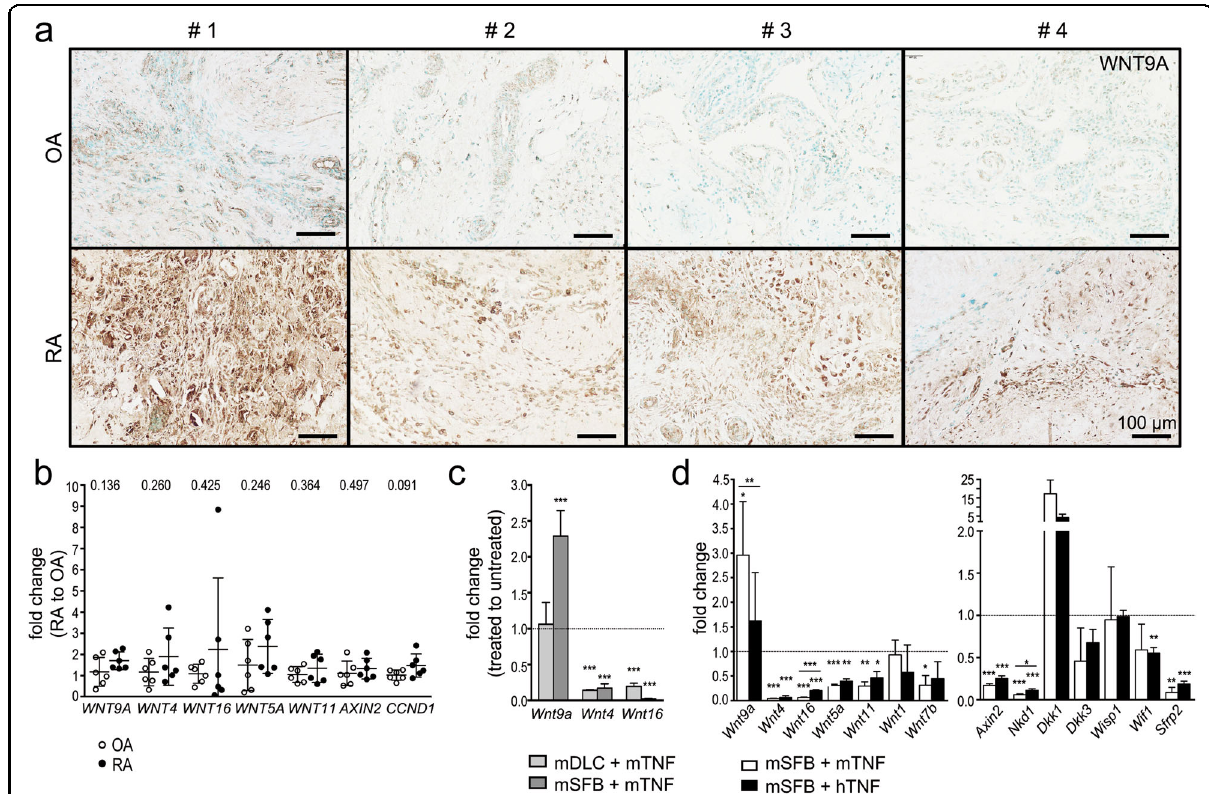
Fig. 1 Expression of Wnt genes under in fl ammatory conditions. a Immunohistological analysis of WNT9a in human OA and RA tissue samples ( n = 4). b qPCR analysis of WNT pathway-related genes in RA relative to OA SFB samples displayed as a dot plot with P -values noted above ( n = 6). c qPCR analysis of murine Wnt9a , Wnt4 , and Wnt16 in cultured deep layered chondrocytes (DLC; n = 3) and synovial fi broblasts (SFB; n = 6) after treatment with murine TNF for 48 h, displayed as relative fold change to untreated cells. d qPCR analysis of Wnt and Wnt pathway-related genes in SFBs treated with recombinant murine TNF (mTNF) or human TNF (hTNF) for 48 h, displayed as relative fold change to untreated cells ( n ≥ 3). P -values: *<0.05, **<0.01, and